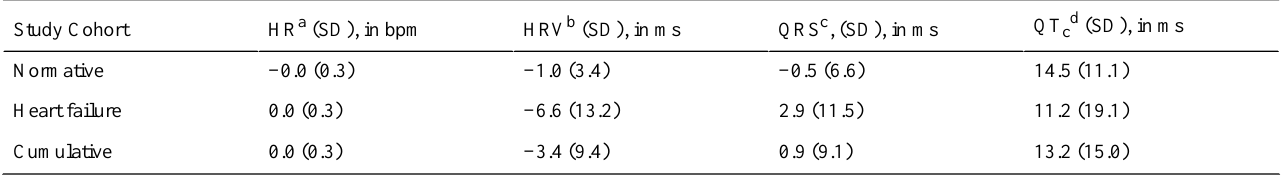
Table 3. Principal cardiac interval results of the buttocks electrocardiogram compared with Lead II for the normative and heart failure